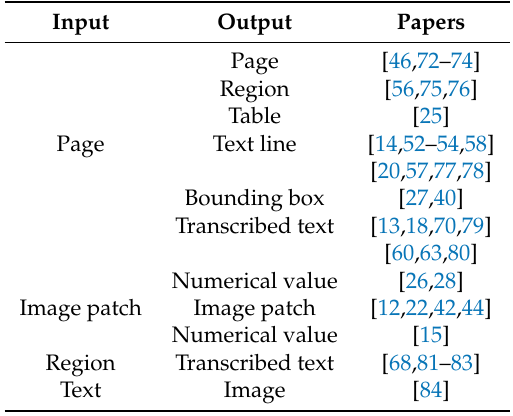
Table 2. Most frequent combinations of input and output types and their